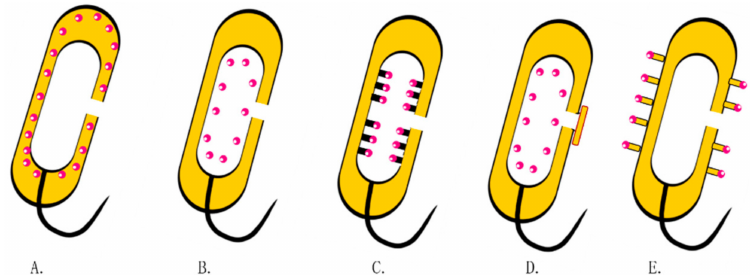
Figure 5. Drug loading strategies in BGs. ( A ) Expressions of proteins or antigens in the periplasmic space through genetic engineering. ( B ) Non-specific binding of drugs to the inner